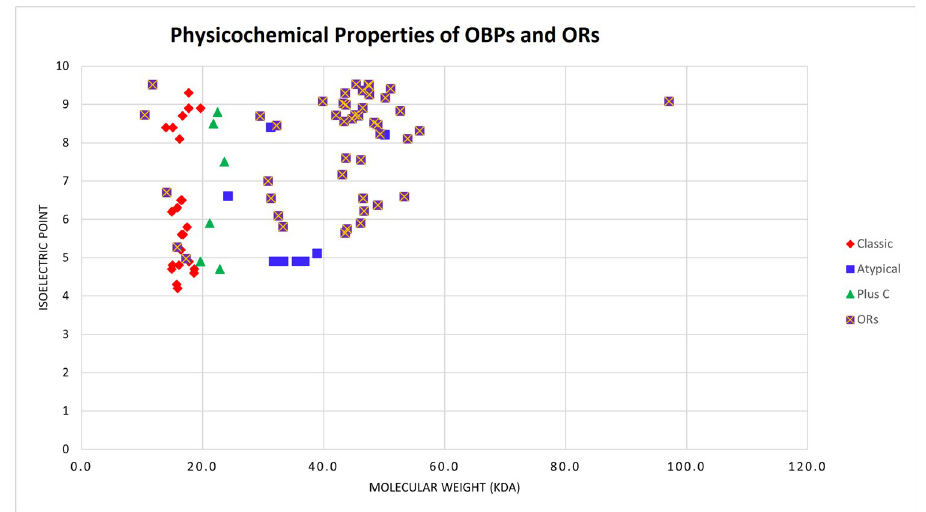
Fig 11. Physicochemical properties of OBPs and ORs. Molecular weight and isoelectric point of the OBPs and ORs are shown as these are important indicators of the OBPs and ORs functions. Atypical OBPs had highest molecular weight among other classes whereas ORs have higher molecular weight than